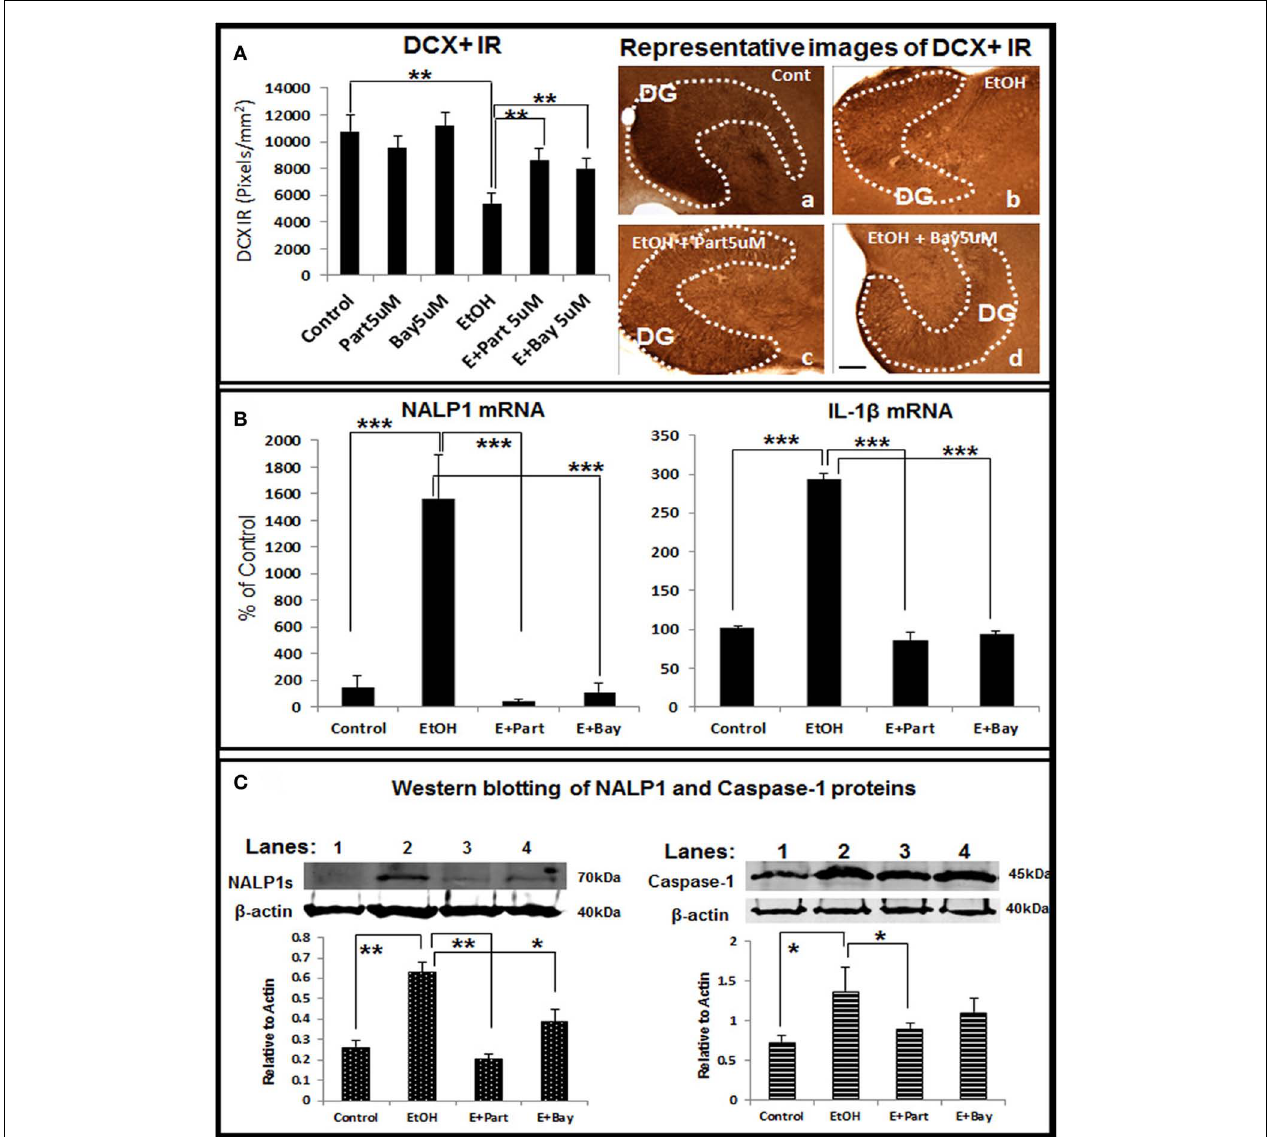
Ethanol + Bay 11-7082 (E + Bay, d ) (scale bar = 200 μ m).The experiments were repeated 3 times with the similar design and results. (B) Ethanol induction of NALP1 and IL-1 β mRNA is blocked by inhibitors parthenolide (Part, 5 μ M, pretreatment for 2h) and Bay 11-7082 (Bay, 5 μ M, pretreatment for 2h). ANOVA following Fisher post hoc : *** p < 0.001 compared with Control or Ethanol, n = 3. (C) Western blot of NALP1 and pro-caspase-1 proteins. Consistent with mRNA data, ethanol exposure strongly induced short form ( ∼ 75kDa) NALP1 and both inflammasome inhibitors blocked ethanol induction of NALP1 protein level (left).Western blot of caspase-1 also indicates increased expression of caspase-1 protein (45kDa) by ethanol exposure (right). ANOVA following Fisher post hoc : ** p < 0.01 compared with control; * p < 0.05 compared with EtOH, n =